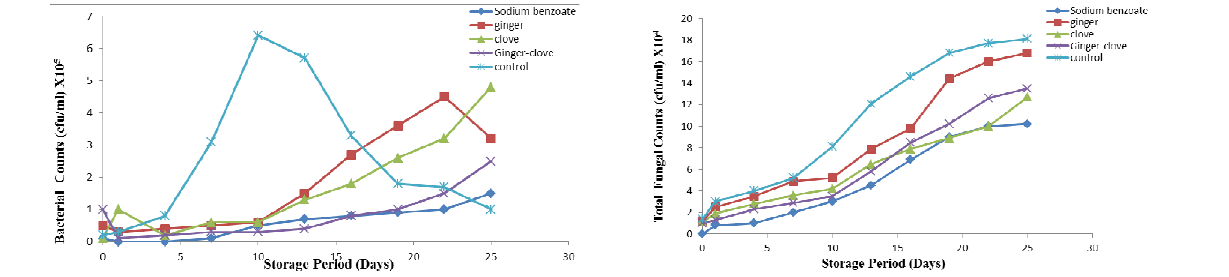
Fig. 4. Effects of different treatments at 1% concentration on the fungal counts of soymilk samples stored at refrigerated temperature for 25 days